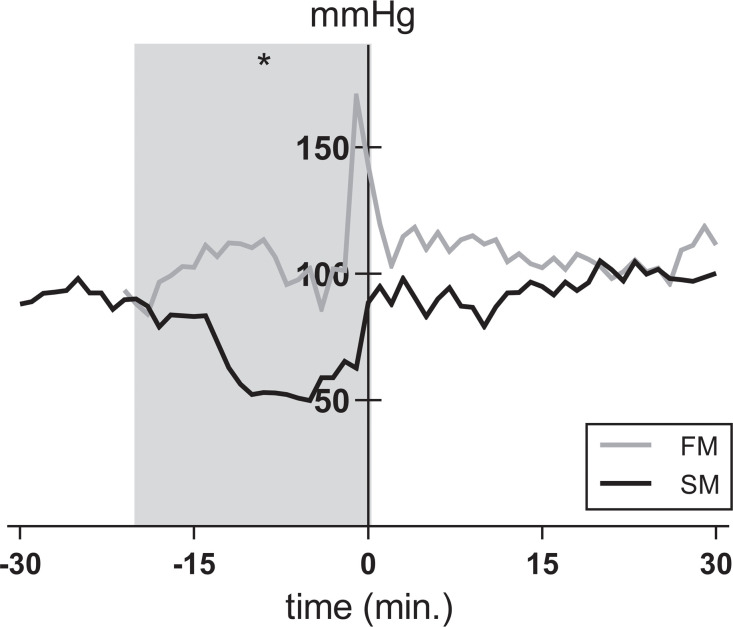
Mean arterial pressure.Rats were subjected to fast brain death (BD) induction (intracranial pressure (ICP) increase over 1 min) versus slow BD induction (ICP increase over 30 min). Expansion of the Fogarty catheter and induction of BD was finished at time point zero in both models. After BD was induced, all animals were stabilized above a mean arterial pressure of 80 mmHg for 0.5–4 hours, of which the first 30 min are presented in this figure. Values are depicted as mean. Data displayed in the grey area are significant between groups, as indicated by the asterisk: * p<0.05. FM–fast BD induction model, expansion of the Fogarty catheter over 1 min; SM–slow BD induction model, expansion of the Fogarty catheter over 30 min.